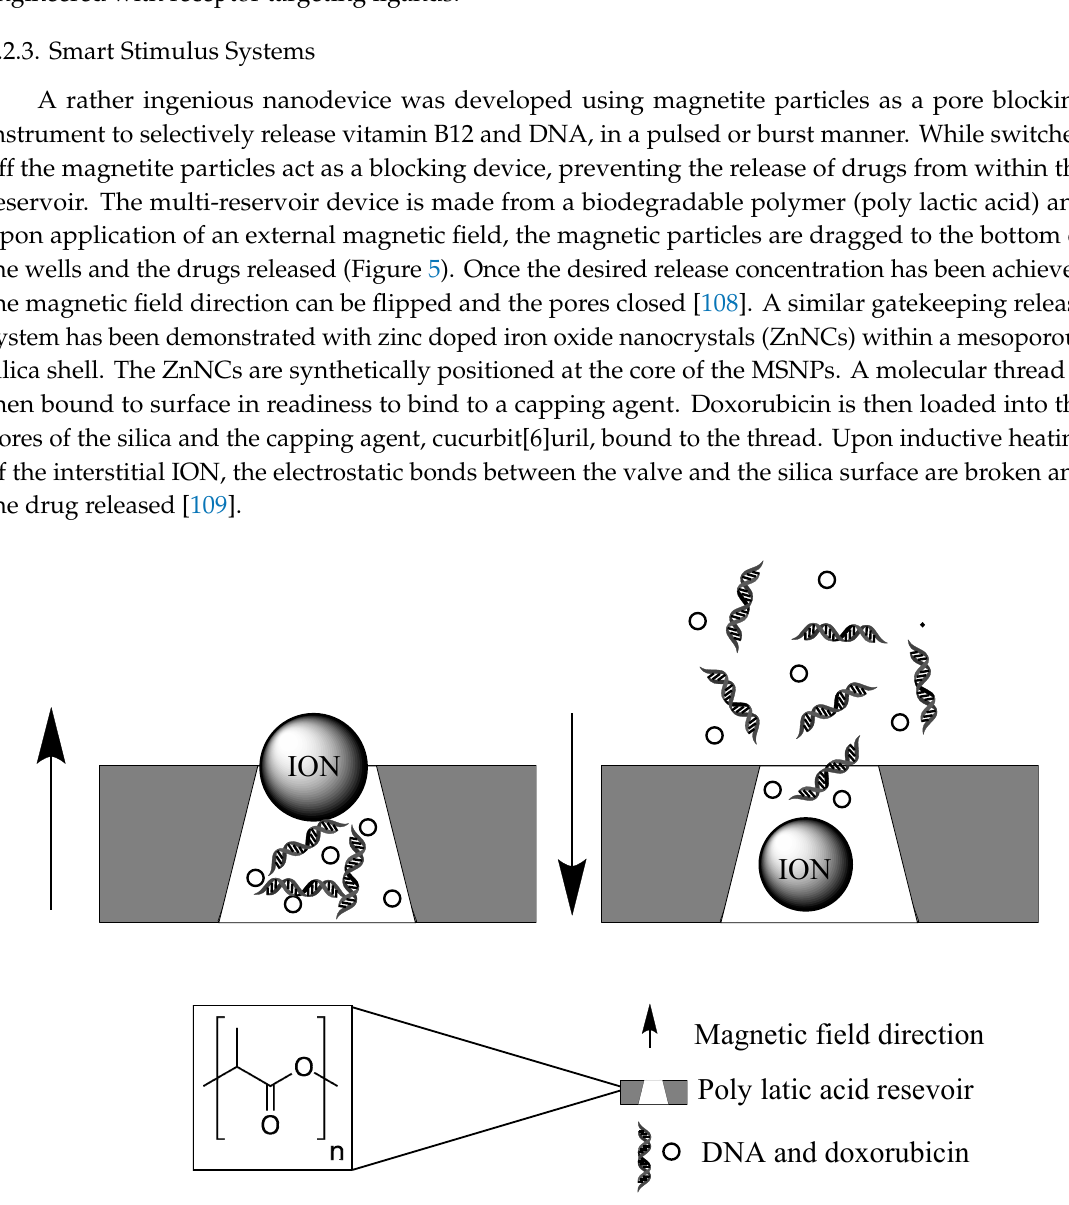
Figure 5. On-off tuneable release mechanism of chemotherapy molecules and gene therapy for